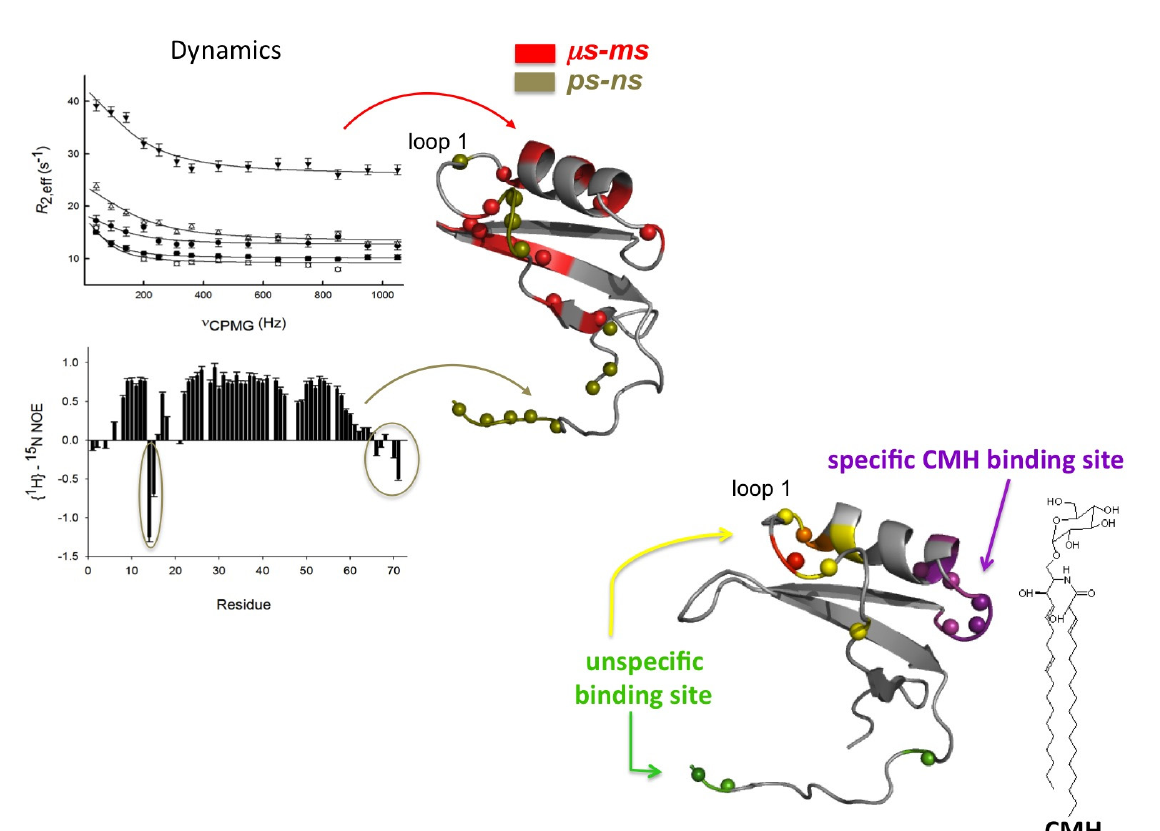
Figure 3. Complex motions of Sd5 probed by backbone relaxation parameters. Residues exhibiting fast motion (ps-ns) are probed using both micelles and vesicles, but those involved in conformational exchange are probed only in the presence of CMH. The regions mapped in membrane recognition with different dynamic properties are highlighted in purple, green and